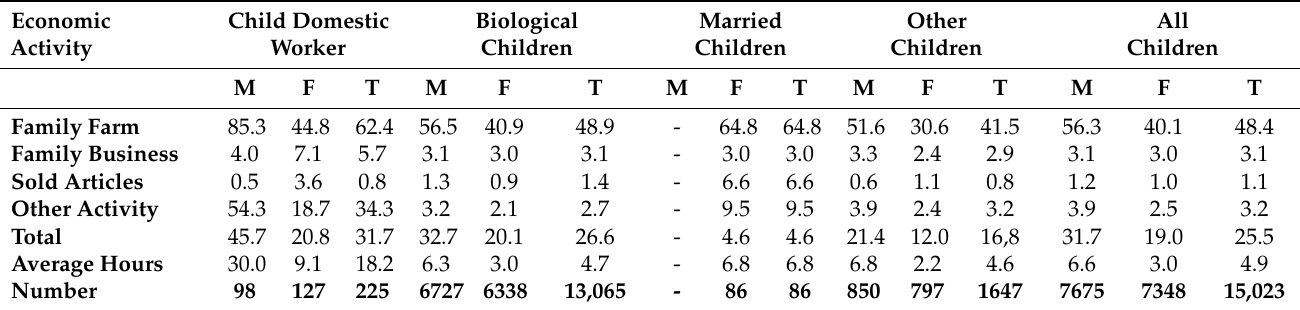
Table 4. Proportion of children engaged in different economic activities and average hours spent by sex ( N = 15,023, %).